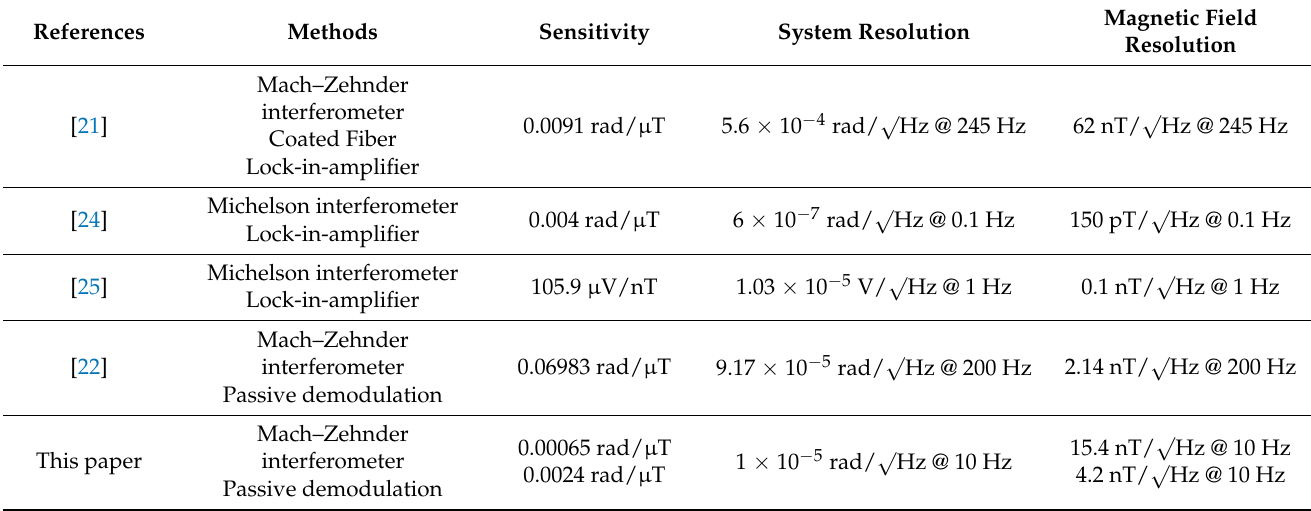
Table 2. Performance comparison of optical fiber magnetic field sensors based on the magnetostrictive